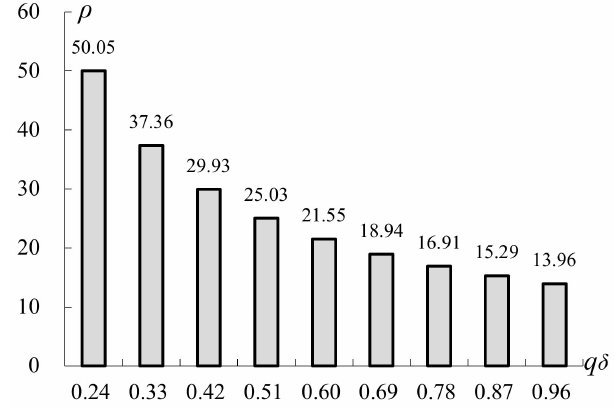
Figure 1. E ff ect of q δ on ρ